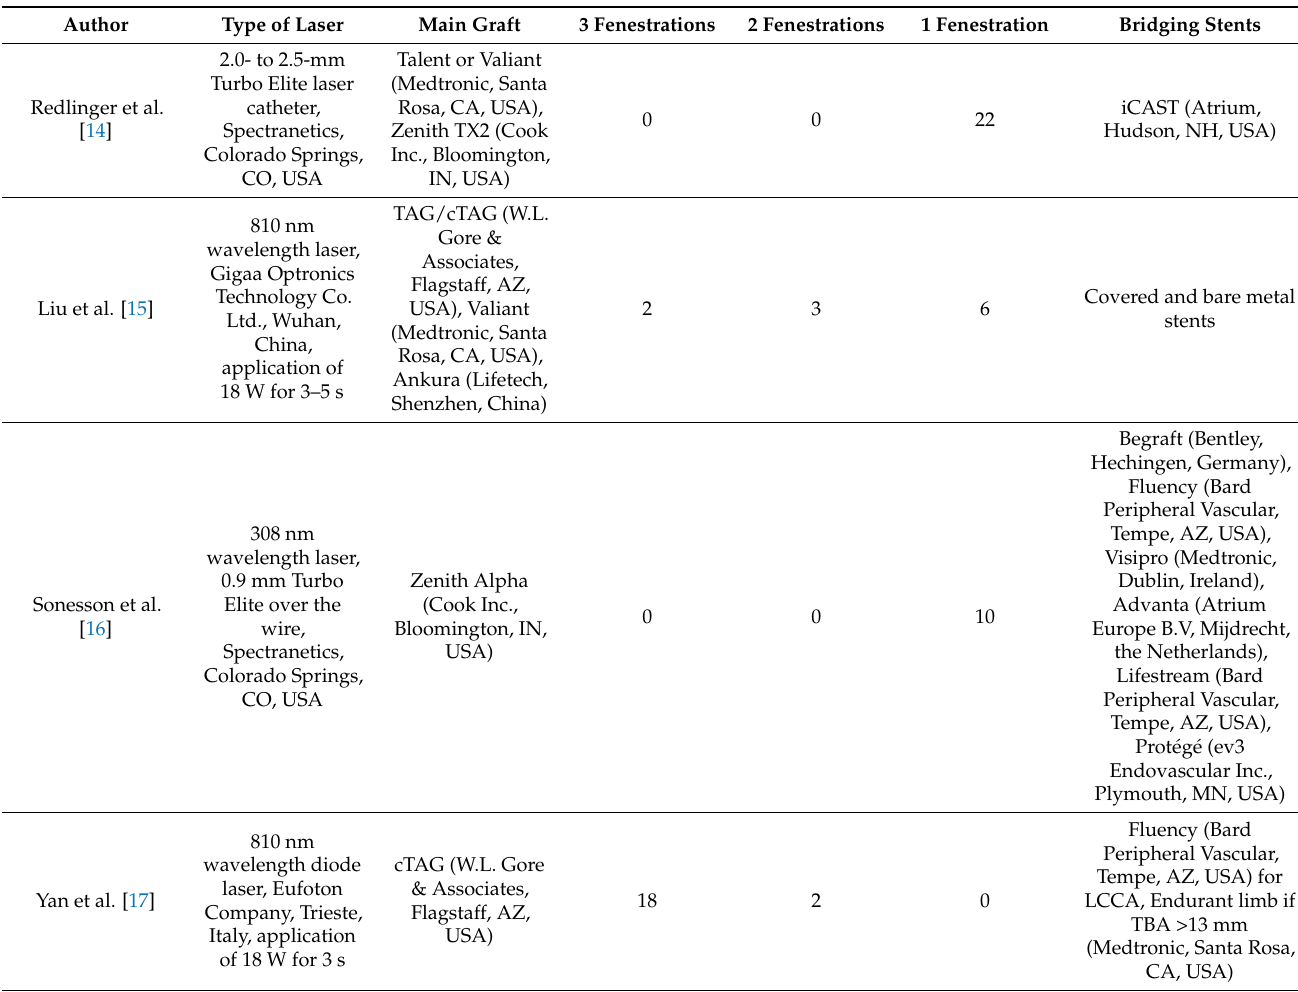
Table 2. Technical characteristics of the devices used for in situ laser FTEVAR including the main endografts and bridging